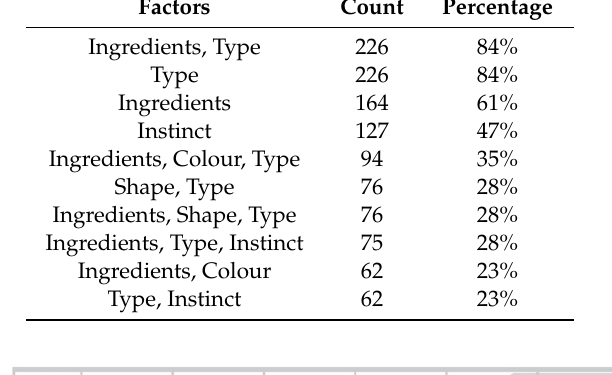
Table 4. Top ten factors or combinations of factors indicated by participants to have influenced the label applied.